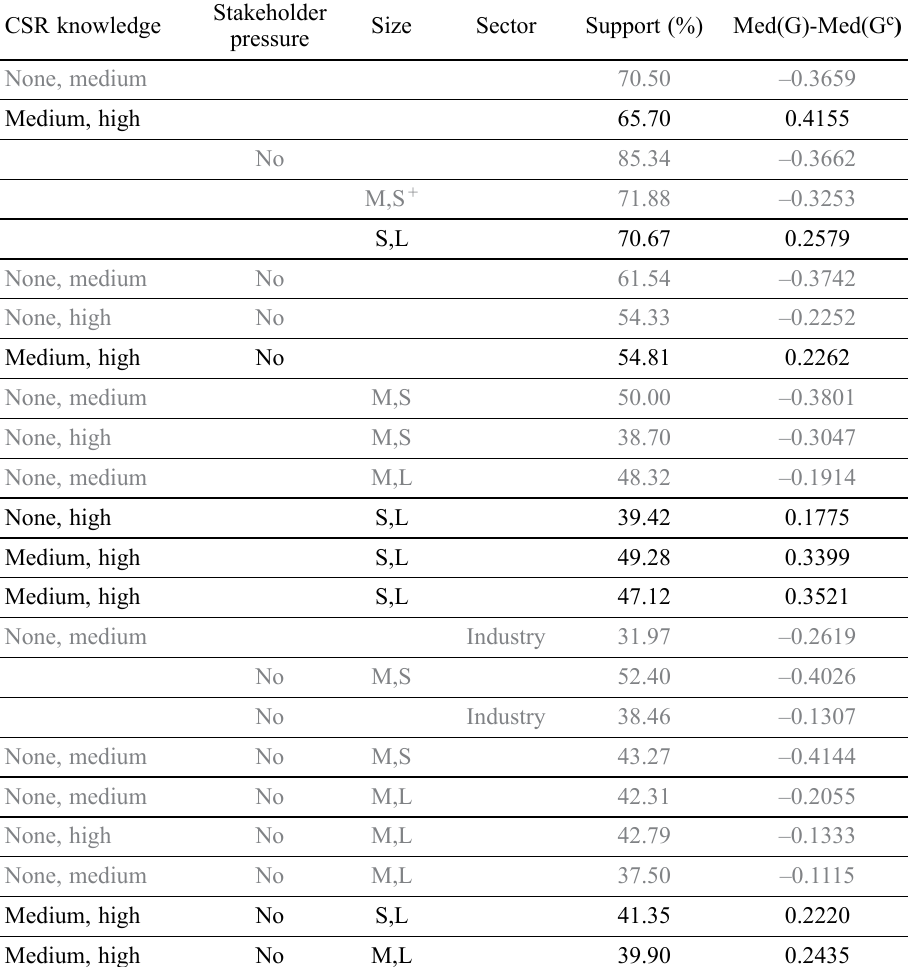
Table 3. Characteristics of the firms with behaviour significantly